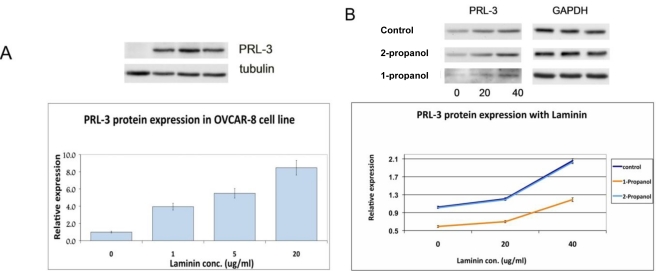
PRL-3 expression in response to laminin stimulation. (A) OVCAR-8 OC cells were exposed to different concentrations of exogenous laminin for 6 h and protein expression evaluated; (B) PRL-3 expression in presence of primary and secondary alcohols. OVCAR-8 OC cells were exposed to various laminin concentrations in the presence of 1-propanol and 2-propanol and protein expression evaluated.